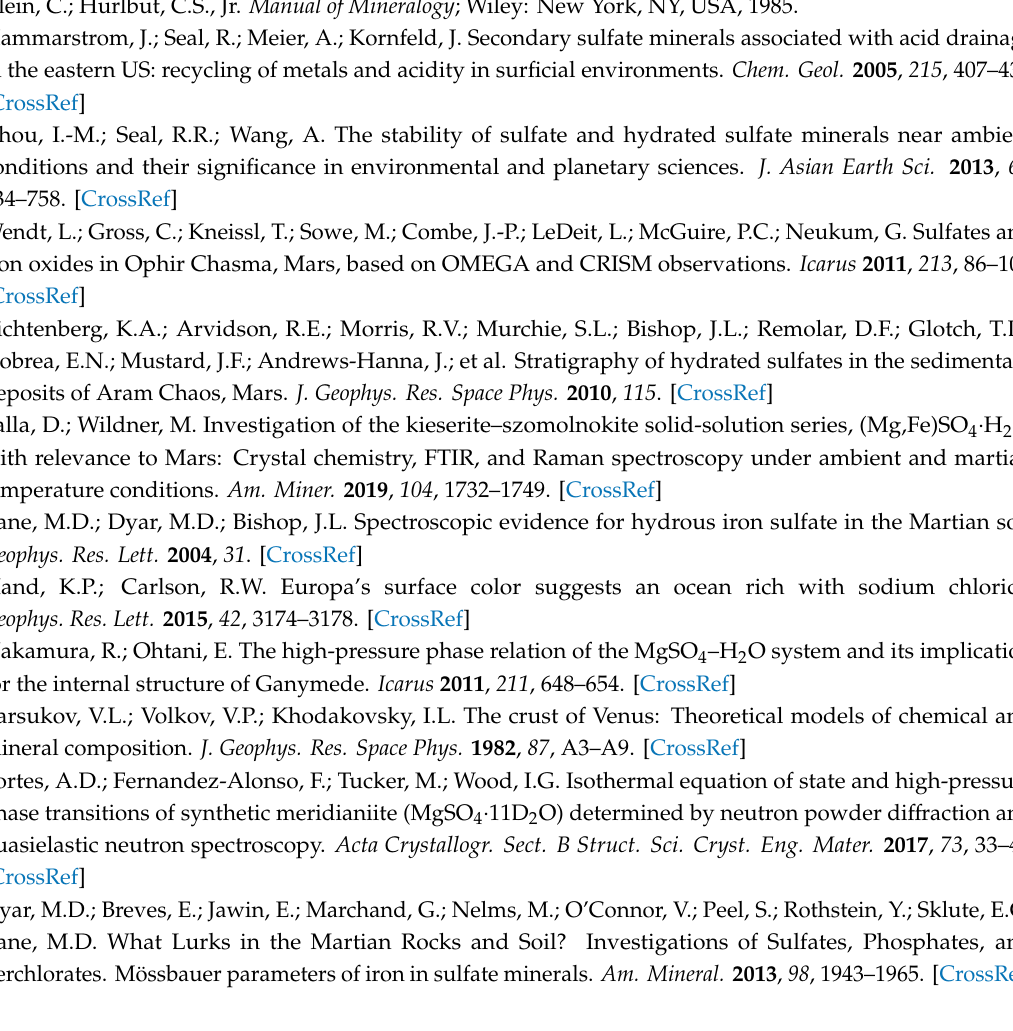
Table S1: Lattice parameters of szomolnokite at ambient pressure and temperature conditions; Table S2: Best fit hyperfine parameters for szomolnokite according to Model 1; Table S3: Best fit hyperfine parameters for szomolnokite according to Model 2; Table S4: Best fit hyperfine parameters for szomolnokite according to Model 3; Table S5: Hydrated iron-bearing sulfates and their experimentally determined quadrupole splitting and isomer shift values at ambient pressure and temperature; Figure S1: The relative IS and FWHM of szomolnokite for Models 1, 2, and